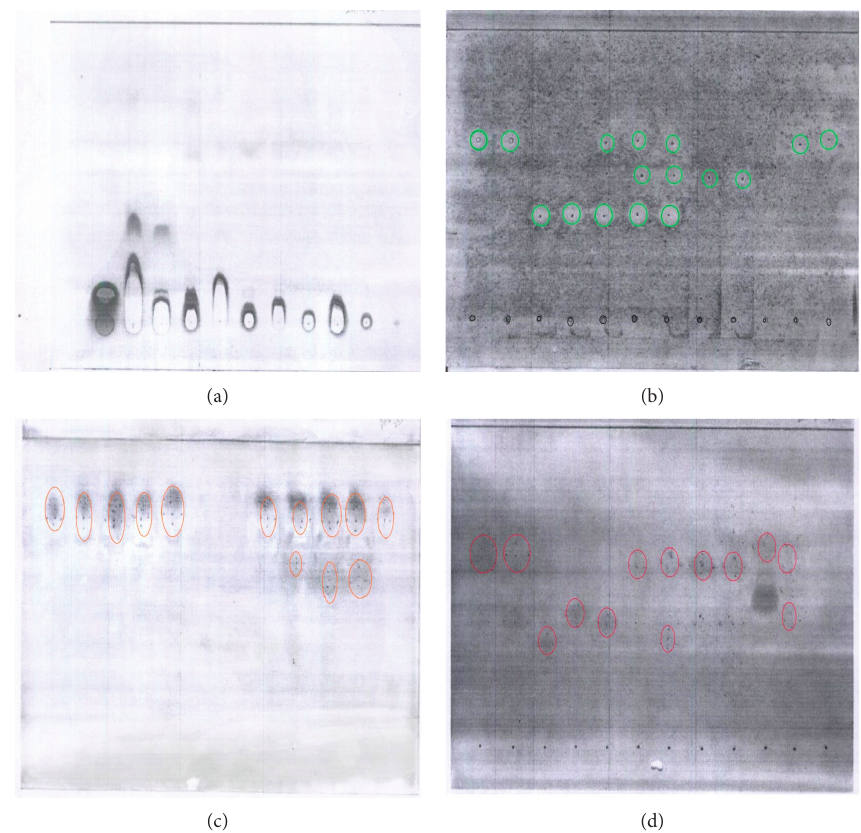
Figure 2: Spot visibility of four used HPTLC methods. (a) Spot visibility of pesticides in the OT+KI method. (b) Spot visibility of pesticides in the fungi spore inhibition method. (c) Spot visibility of pesticides in the horse blood serum method. (d) Spot visibility of pesticides in the photosynthesis inhibition (hill reaction) method.